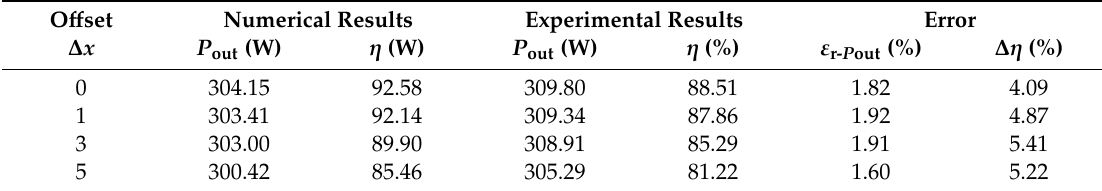
Table 5. Results of the noncoaxial